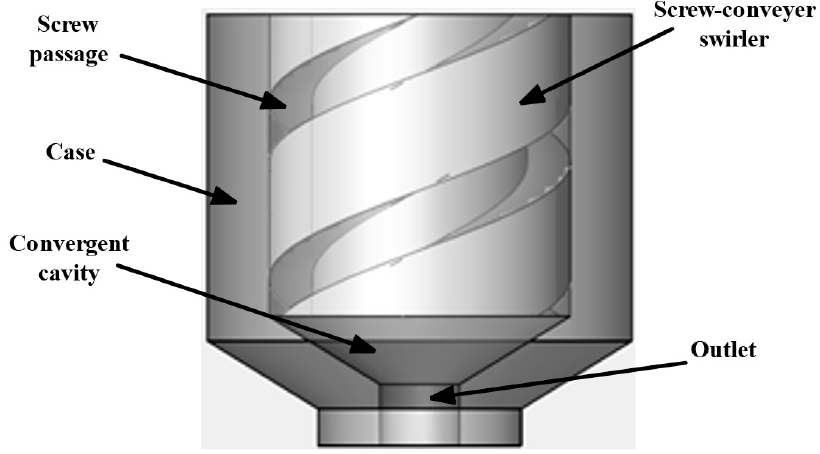
Figure 3. Schematic of the screw conveyor swirl injector.